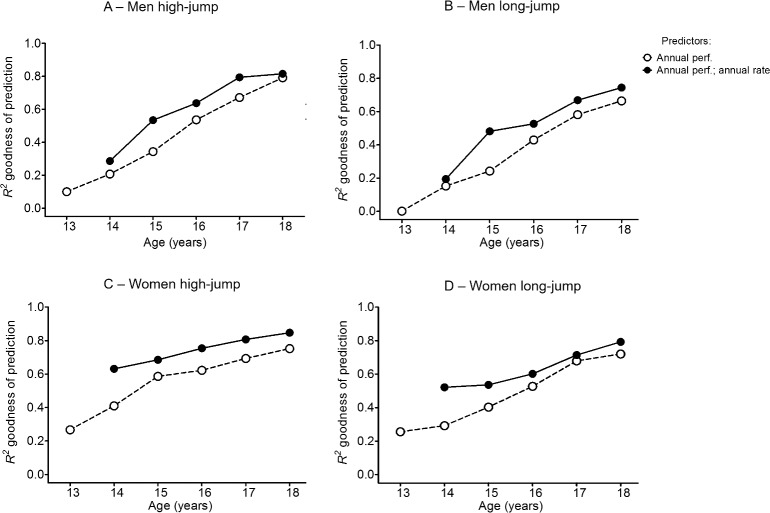
Goodness personal best prediction.In the Fig 4 are reported the R2 coefficients, as indices of prediction goodness, resulted from the multiple regression analysis conducted from 13 to 18 years old. When both annual best performance and annual rate of change were included in the regression model as independent factors (filled circles) the goodness of prediction was consistently greater than using only annual best performance as independent factor (empty circles). The annual rate of change from 12 to 13 years are not reported because the samples were too small to perform the analysis. The data are reported for men high-jump (A), men long-jump (C), women high-jump (C) and women long-jump (D) groups.